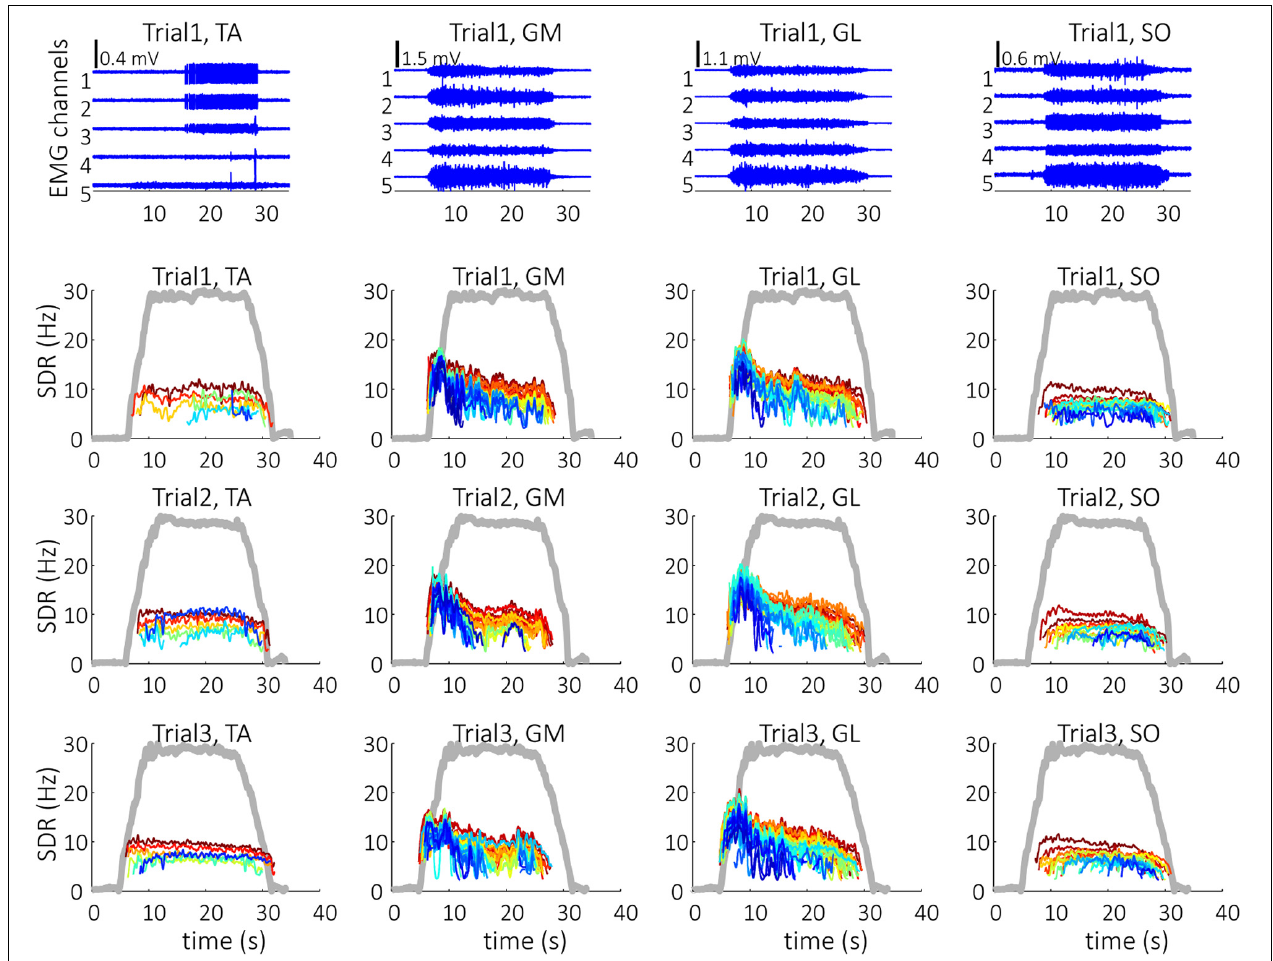
FIGURE 4 | Single differential hdEMG channels (top panels) and smoothed discharge rates (SDR) of individual motor units (panels in the three bottom rows), as identified from the hdEMG signals of older participant (O1). The three trials were performed after the bed rest at 30% MVC torque. TA, Tibialis anterior;